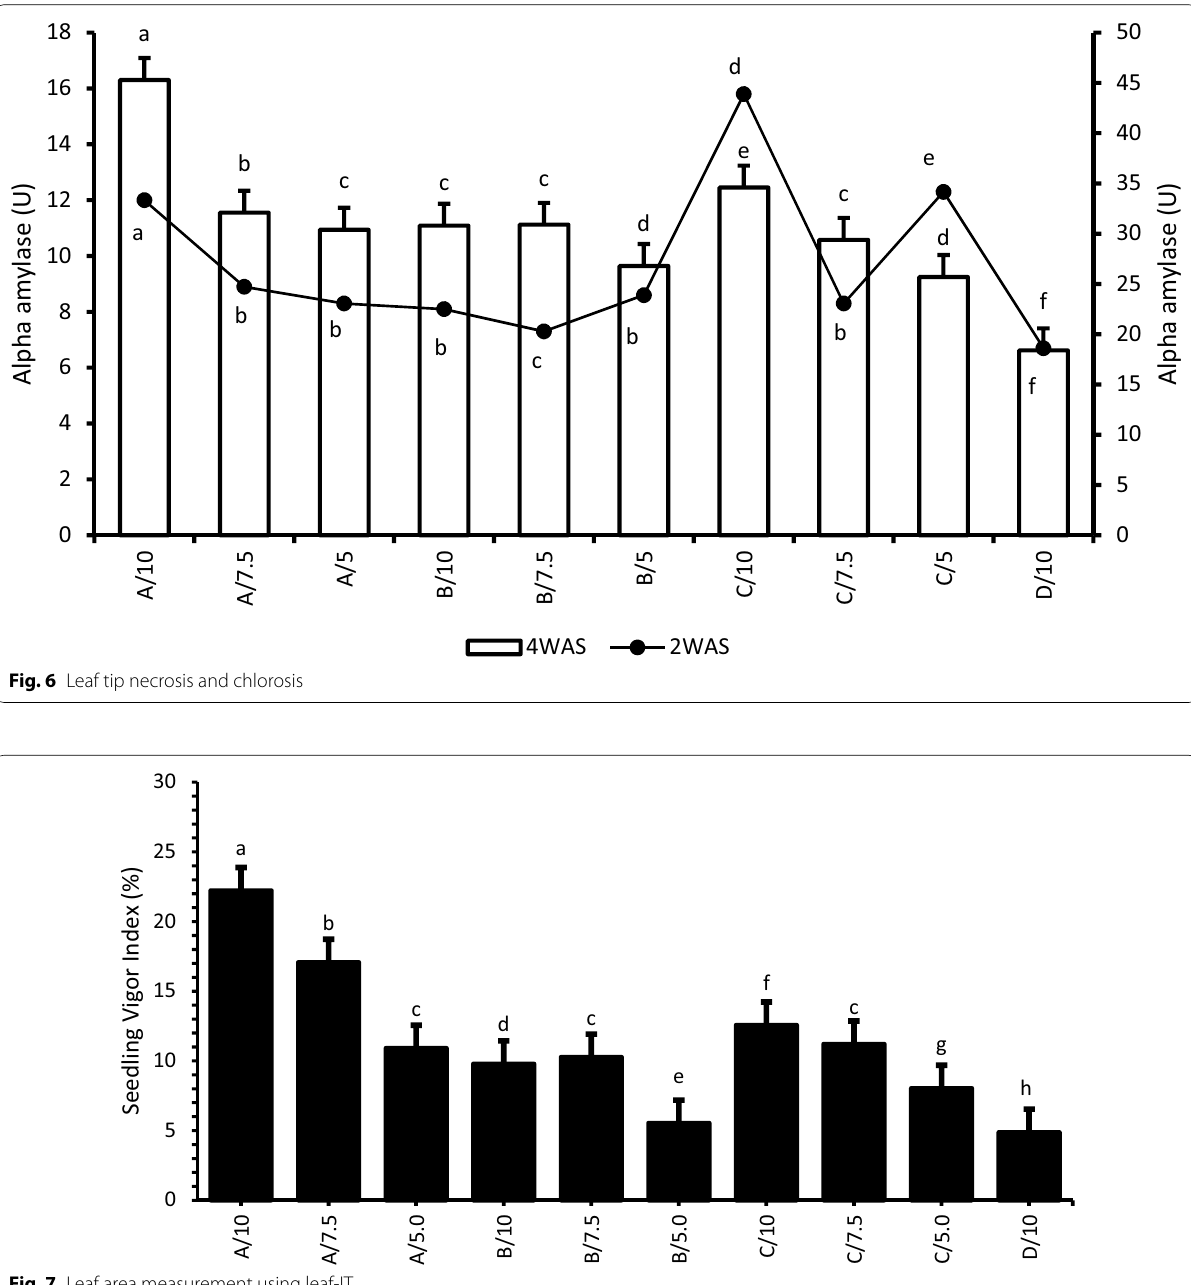
Fig. 7 Leaf area measurement using